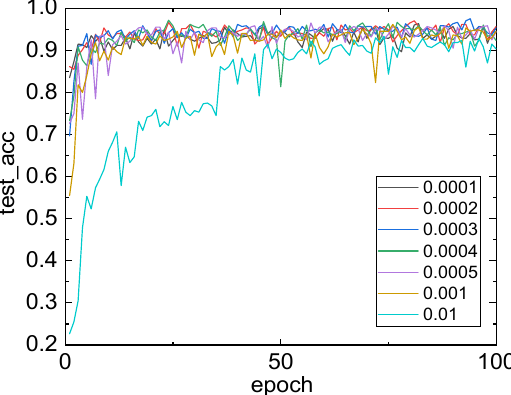
( b ) training accuracy of ResNet-50 with attention mechanism at different learning rate